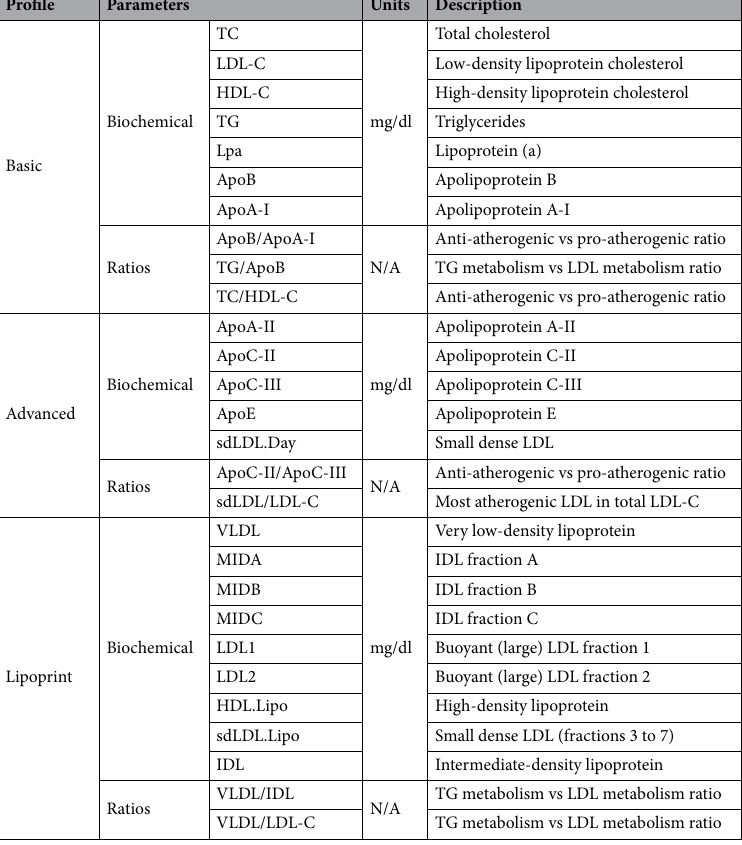
Table 1. Description of the biochemical parameters and ratios in each lipid profile—‘Basic’, ‘Advanced’ and ‘Lipoprint’. N/A not